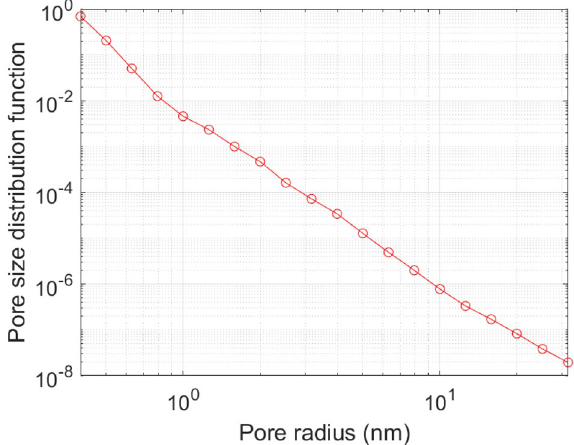
Figure 8. Sub-micron pore size distribution from SAXS for ORS.